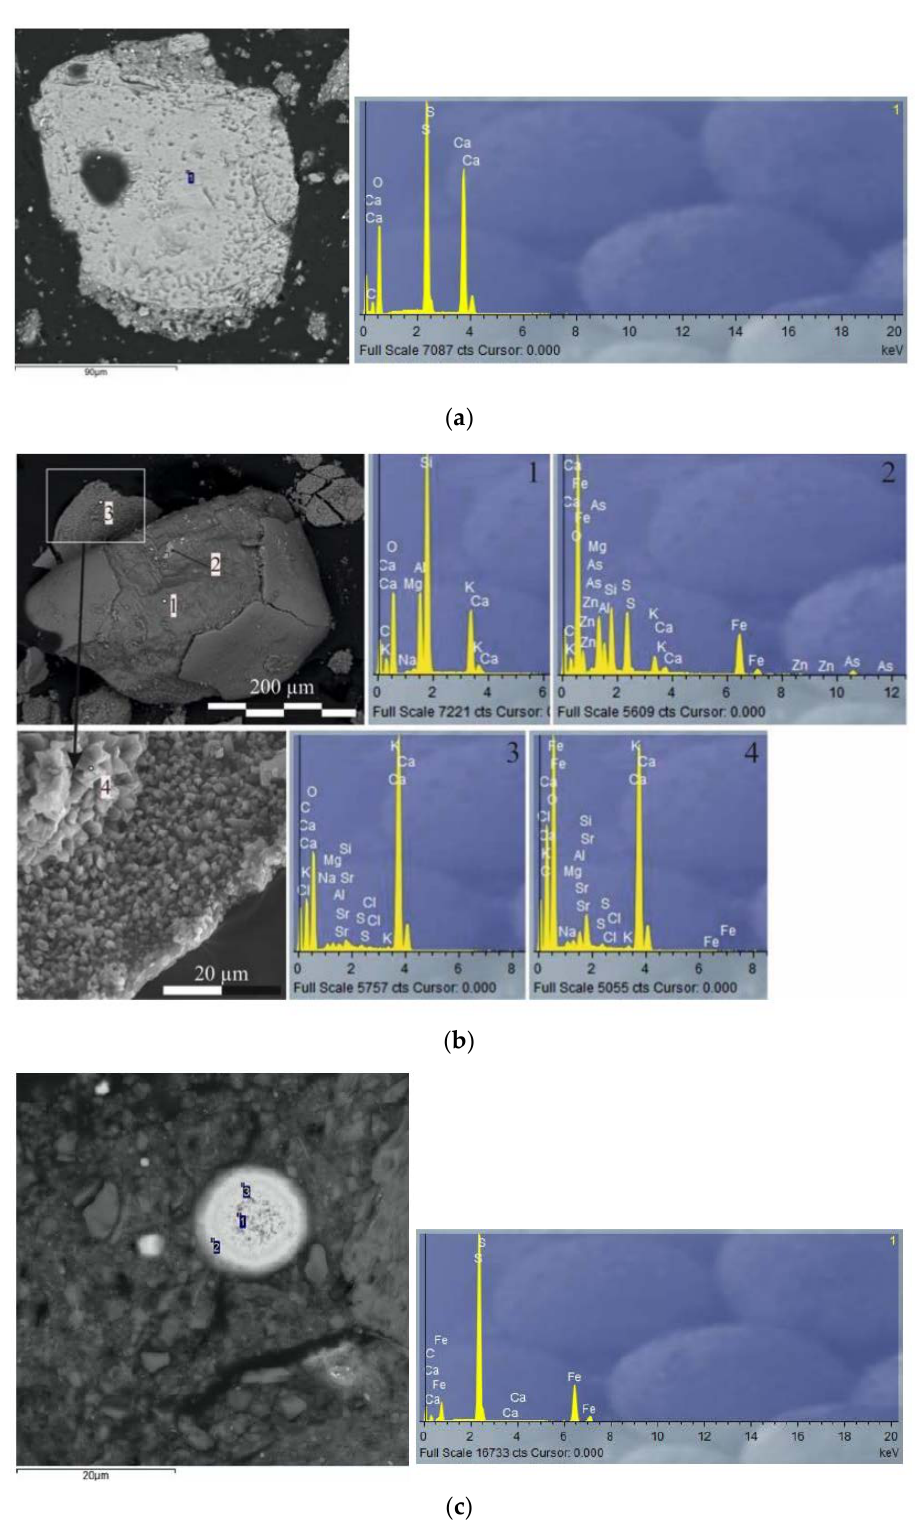
Figure 7. SEM images of: ( a ) anhydrite crystal (3.27–3.32 m); ( b ) the rounded feldspar grain (1) in a “shell” of calcium carbonate (3, 4): mineral phase contains As (3.06%), Zn (0.16%) (0.6–0.7 m) and ( c ) Pyrite in framboid texture.